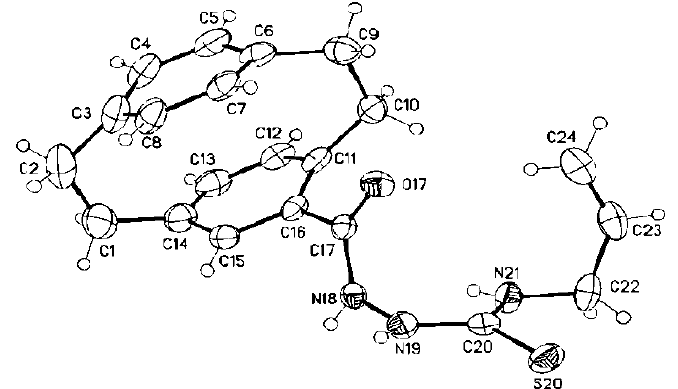
Figure 6. Molecular structure of compound 2d identified according to IUPAC nomenclature as 2-(1,4(1,4)-dibenzenacyclohexaphane-1 2 -carbonyl)- N -vinylhydrazine-1-carbothioamide.